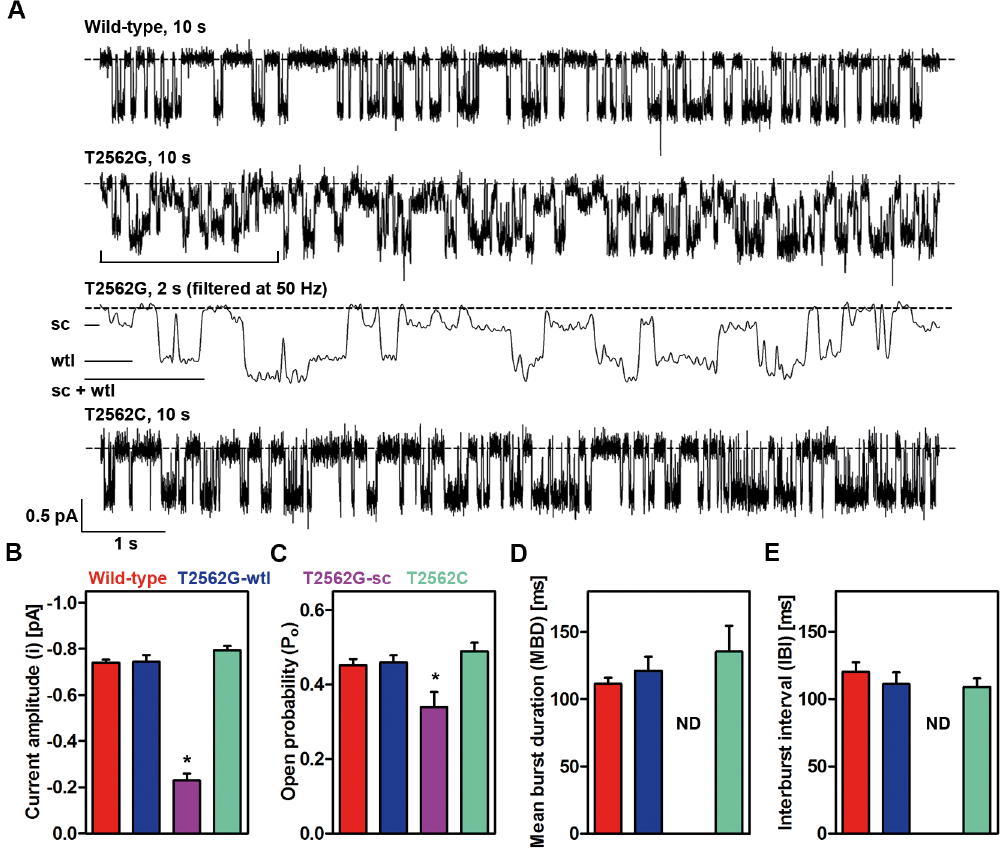
Fig 3. T2562G-CFTR exhibits 2 types of channel openings. ( A ) Representative single-channelrecordingsof CFTR variants in excised inside-outmembranepatches from CHO cells. For wild-typeand T2562C-CFTR, the membranepatches contained1 channel; for T2562G-CFTR, it contained2 channels—one with small conductance (sc) and the other with wild-type–like (wtl) openings. Dashedlines indicatethe closed channelstate and downward deflections correspond to channelopenings.For T2562G-CFTR, the indicated2-s portion is shown on an expanded time scale after filtering digitally. ( B–E ) Single-channelcurrent amplitude( i ), open probability( P o ), mean burst duration(MBD), and interburst interval (IBI) of CFTR variants. Data are means ± SEM ( n = 5–9); * P < 0.05 versus wild-typeCFTR; ND, not determined.The underlyingdata of panelsB–E can be found in S1